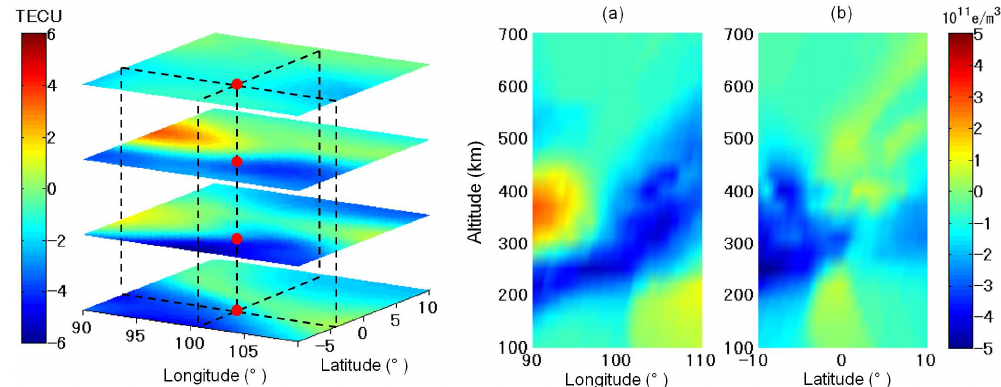
Fig. 11. Example of electron density distributions (07:30–07:45UT). The red dots indicate the projection of the epicenter. Left panel indicates the IECs. (a) Longitudinal difference in electron density between the observed data and the reference data at the same latitude of epicenter (4.520 ◦ S). (b) Latitudinal difference in electron density between the observed data and the reference data at the same longitude of the epicenter (101.374 ◦ E).